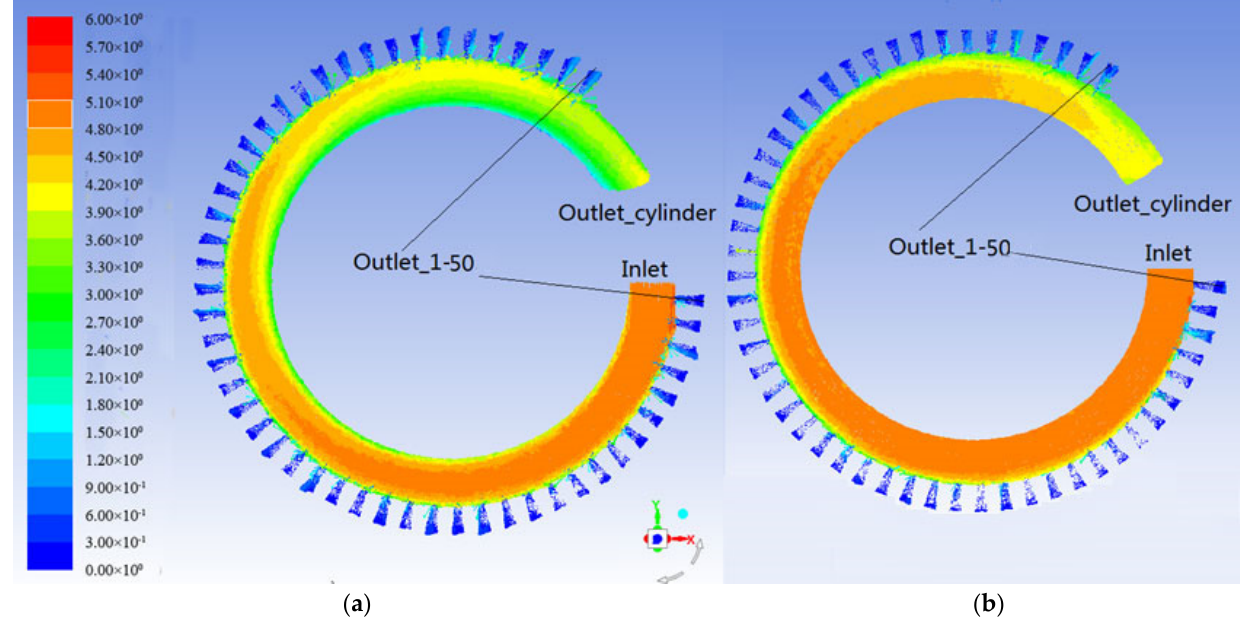
( b ) Figure 5. Distribution of ( a ) the mass flow of screen underflow and ( b ) the proportion of screen underflow for ideal and viscous fluid under different inlet velocities (1~20 m/s). When multiple screen apertures are present along the fluid movement direction, the fluid permeation behaviour can be viewed as the sum of the fluid permeation behaviour in each screen aperture. Thus, 50 screen apertures were used to model the geometry in the